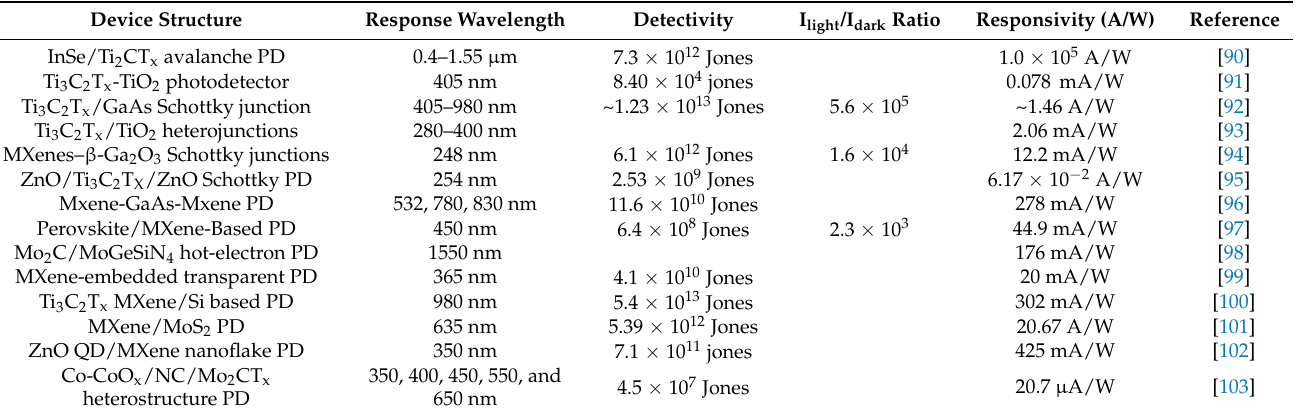
Table 2. PDs based on